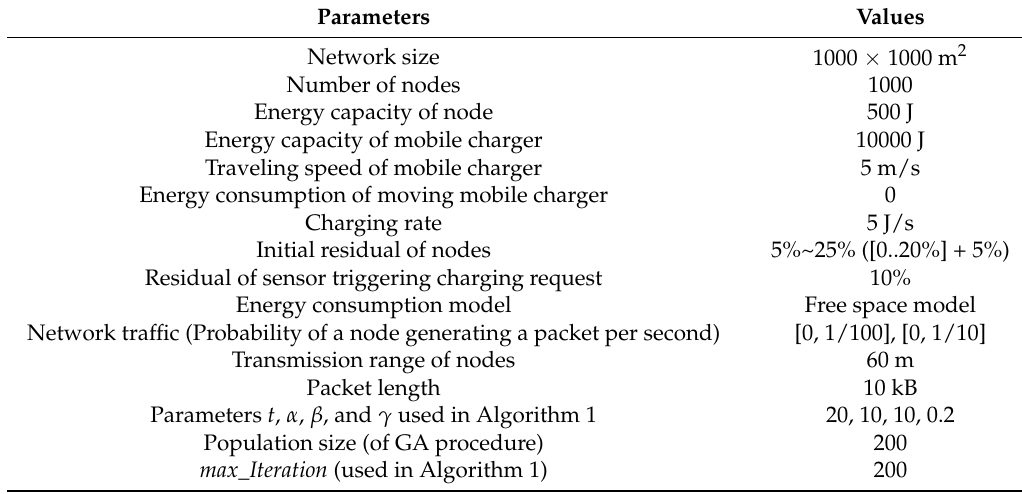
Table 2. Simulation parameter settings.